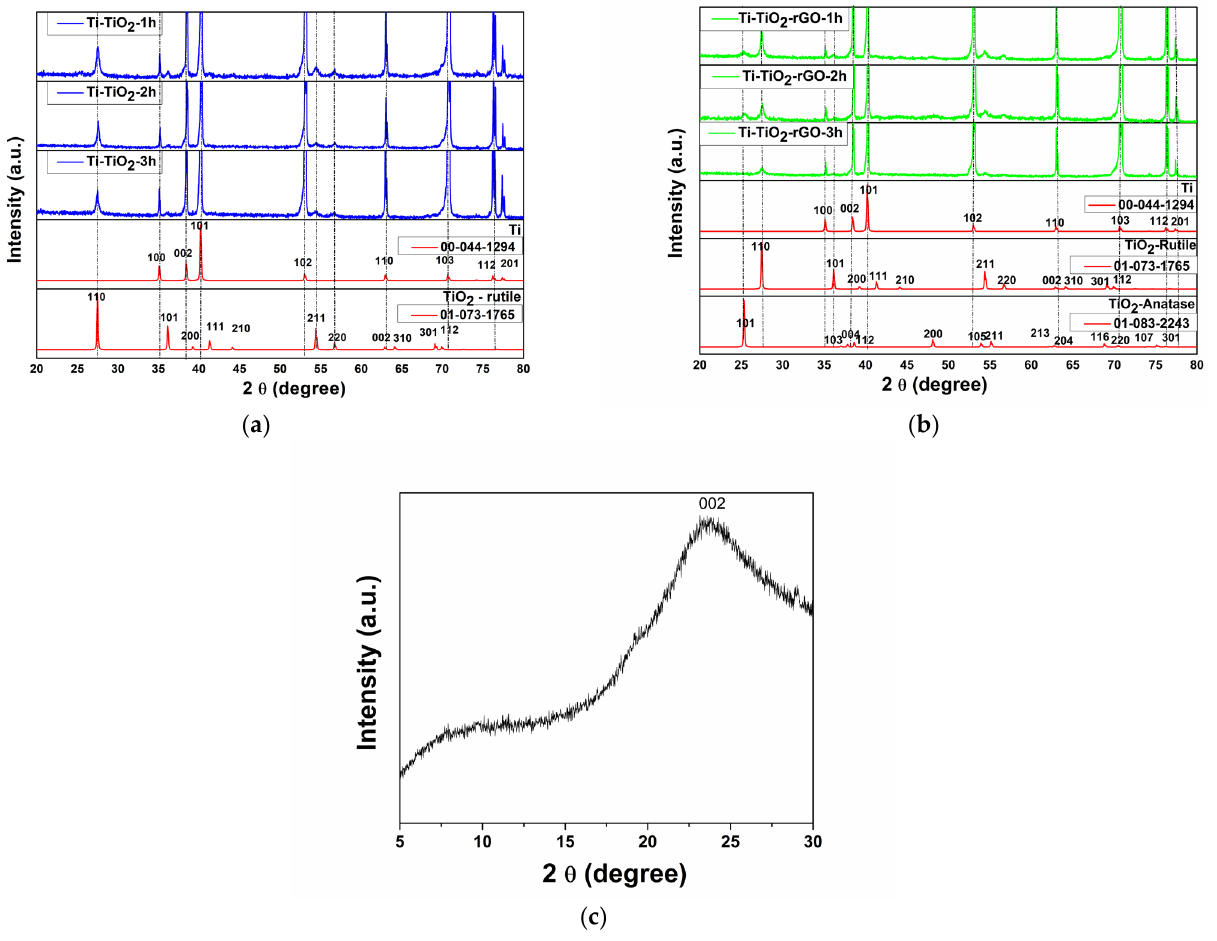
Figure 2. X-ray patterns of the as-obtained structures; ( a ) Ti-TiO 2 layers; ( b ) Ti-TiO 2 -rGO composites; ( c ) pure rGO.